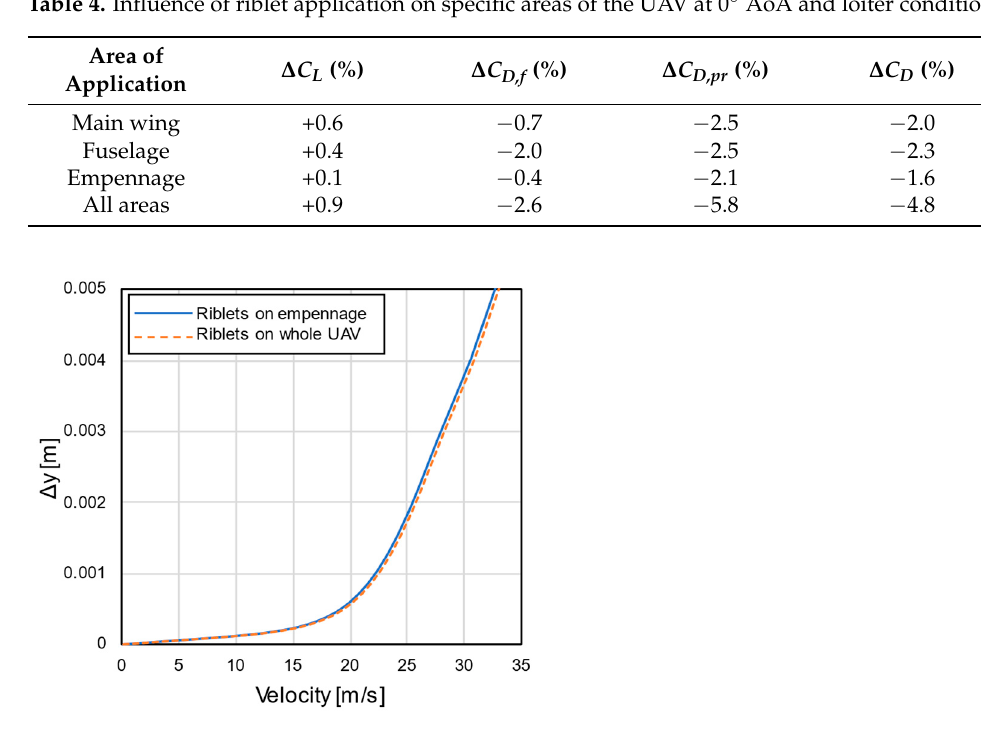
Figure 11. Velocity profiles on the empennage plane at x / c = 0.85 with riblet application only on the empennage and on the whole UAV. Table 4. Influence of riblet application on specific areas of the UAV at 0° AoA and loiter conditions.